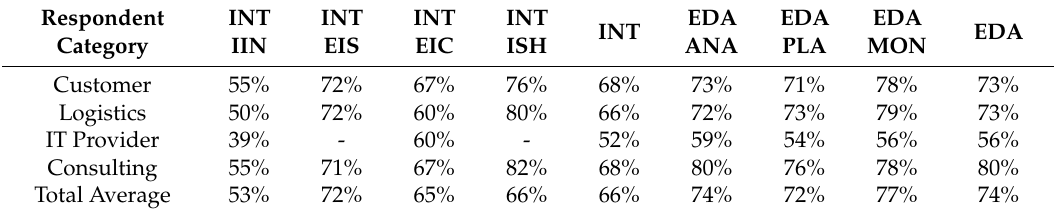
Table 2. Results concerning 4PL service of integration and 4PL effective data